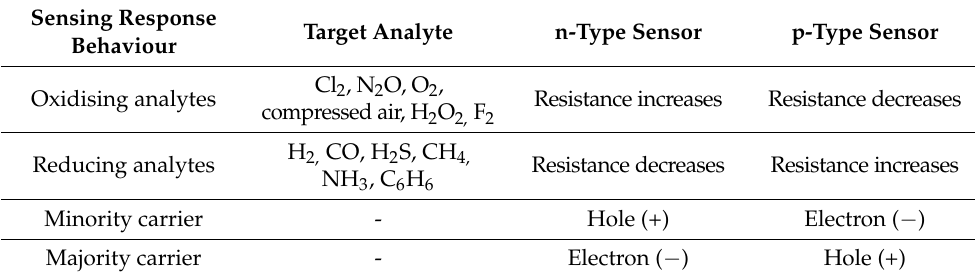
Table 3. Sensing mechanism of resistive